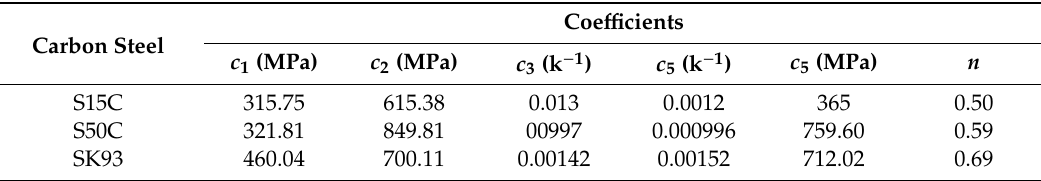
Table 2. Calculated values of Zerilli–Armstrong coe ffi cients